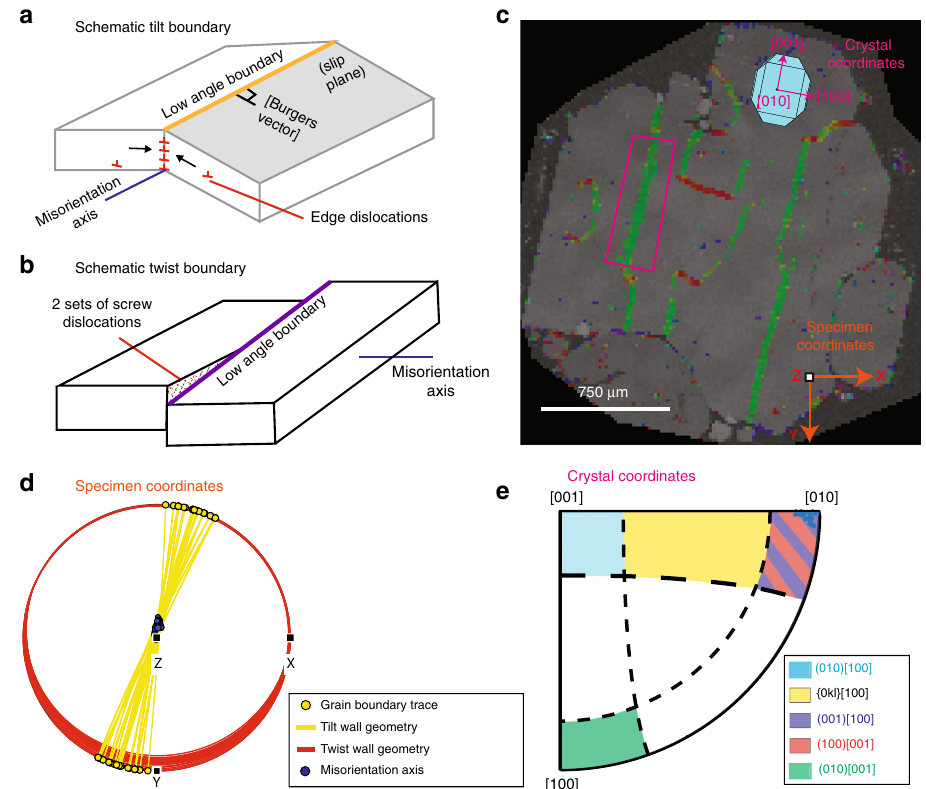
Fig. 7 Slip system identi fi cation method developed for this study. a A schematic diagram of a tilt boundary, where the misorientation axis lies within the plane of the low angle (subgrain) boundary. b A schematic diagram of a twist boundary, where the boundary plane is perpendicular to the misorientation axis. Two sets of screw dislocations are shown within the twist wall for illustrative purposes; this is just one possible geometry. c Map of weighted Burgers vector directions (WBVDs) in a deformed olivine. Specimen coordinates (orange arrows) represent the x , y , and z directions within the scanning electron microscope. Crystal coordinates (pink arrows) represent the directions of the [100], [010], and [001] axes of the olivine. A 3D olivine crystal is overlain to demonstrate the orientation of the crystal in crystal co-ordinates. Boundaries with [100] WBVDs are almost parallel to the y direction, while those with [001] WBVDs are almost parallel to the x direction in specimen coordinates. A small section of a [100] WBVD boundary is selected for further discussion (pink rectangle). d Ideal tilt (yellow) and twist (red) boundaries calculated for each boundary segment in the pink rectangle based on the trace of the subgrain boundary and direction of the misorientation axis (in specimen coordinates). As the calculated twist wall planes show extremely low dips, the MTEX code classi fi es all segments along this boundary as tilt walls. e Schematic diagram showing the misorientation axes in crystal coordinates for tilt boundaries built from dislocations types associated with each of the 5 olivine slip systems (written as (slip plane)[Burgers vector]), allowing 20° leniency. Misorientation axes of the boundary pixels within the pink rectangle plot near [010]. Along with the [100] WBVDs, this indicates that this tilt wall consists of (001)[100]